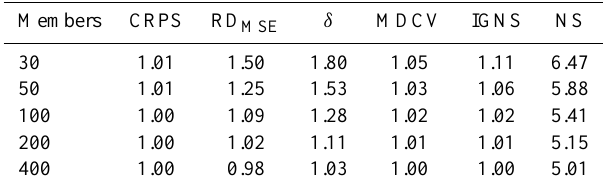
Table 5. Results of BGS in catchment H36 for the lead time 9 with the combined criterion as error function. The scores are presented in a standardized fashion and oriented at the minimization coinciding with the formulation of the Eq.